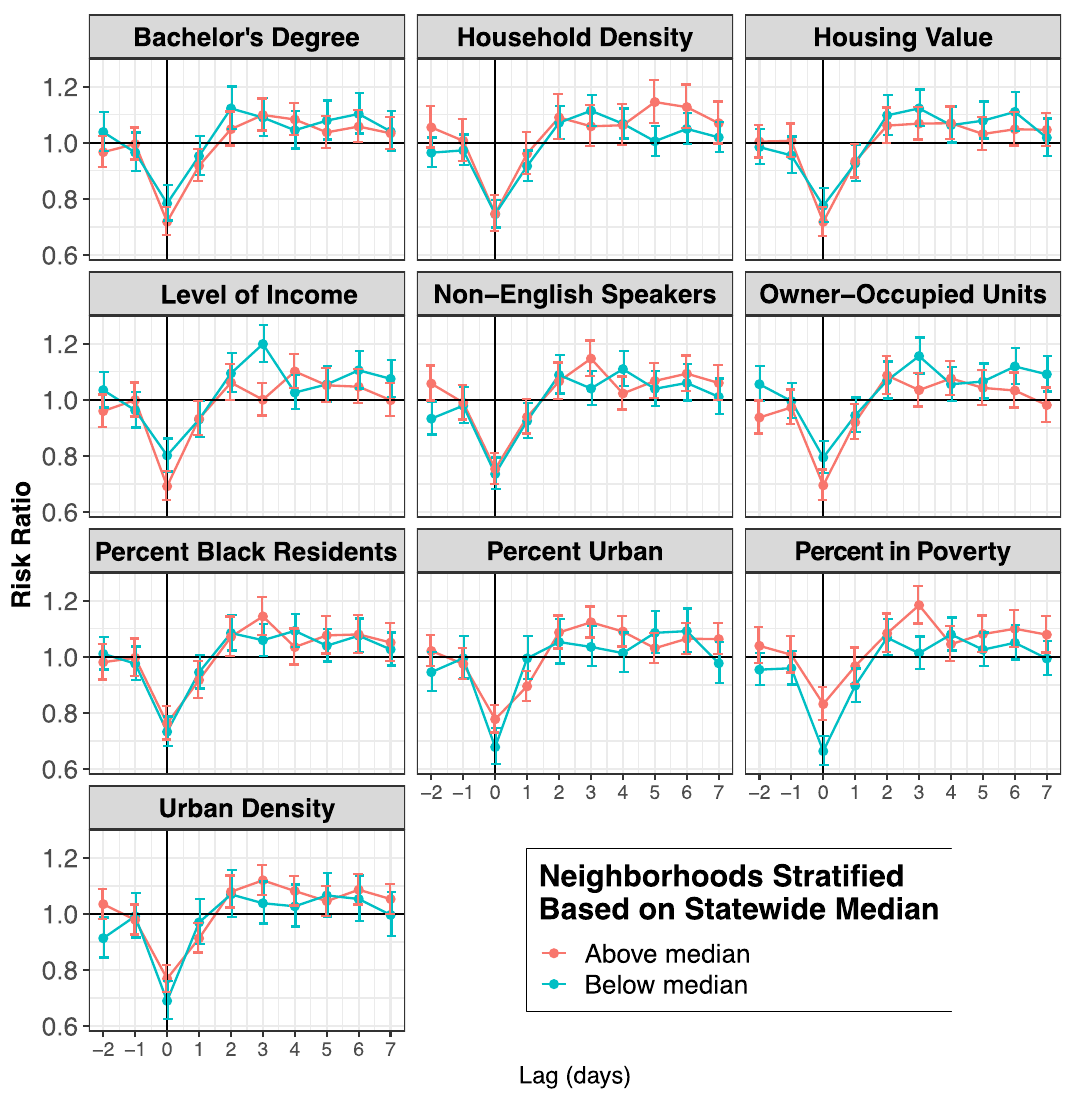
Fig.5|AssociationbetweentropicalcycloneexposureandCVDhospitalization riskinFloridaZCTAs( n =796)from1999to2016,bylag(from2daysbeforeto 7 days after a storm day), strati fi ed by neighborhood-level characteristics